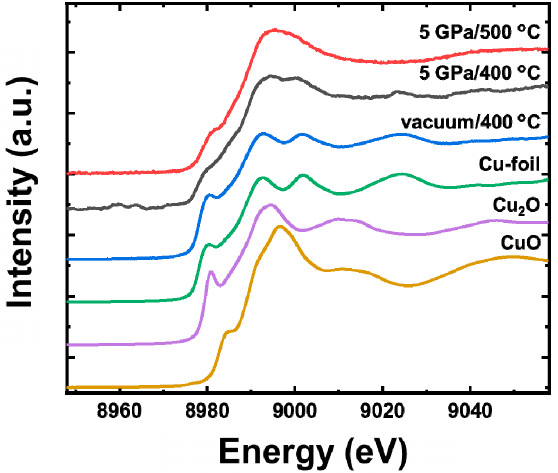
Figure 4. XANES spectra of MOF-derived Cu@C and reference samples. Table 2. XANES analysis for Cu valency of MOF-derived Cu@C materials.